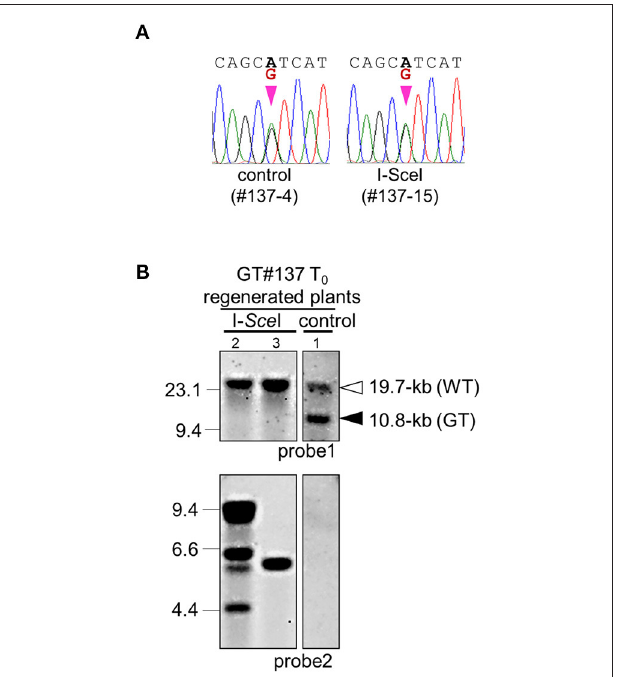
FIGURE 4 | Molecular analysis to confirm GT and marker excision events in GT#137. (A) Sequencing chromatograms of regenerated plants GT#137-4 and GT#137-15 transformed with control and I- Sce I vector, respectively. Sequences were determined using fragments amplified with primer set (C) in Figure 1B . (B) Southern blot analyses with probe 1 or 2 using Eco RV or Msc I-digested genomic DNA, respectively. Samples are regenerated plants of GT#137 transformed with the I- Sce I vector or control vector. Details as in Figure 3B